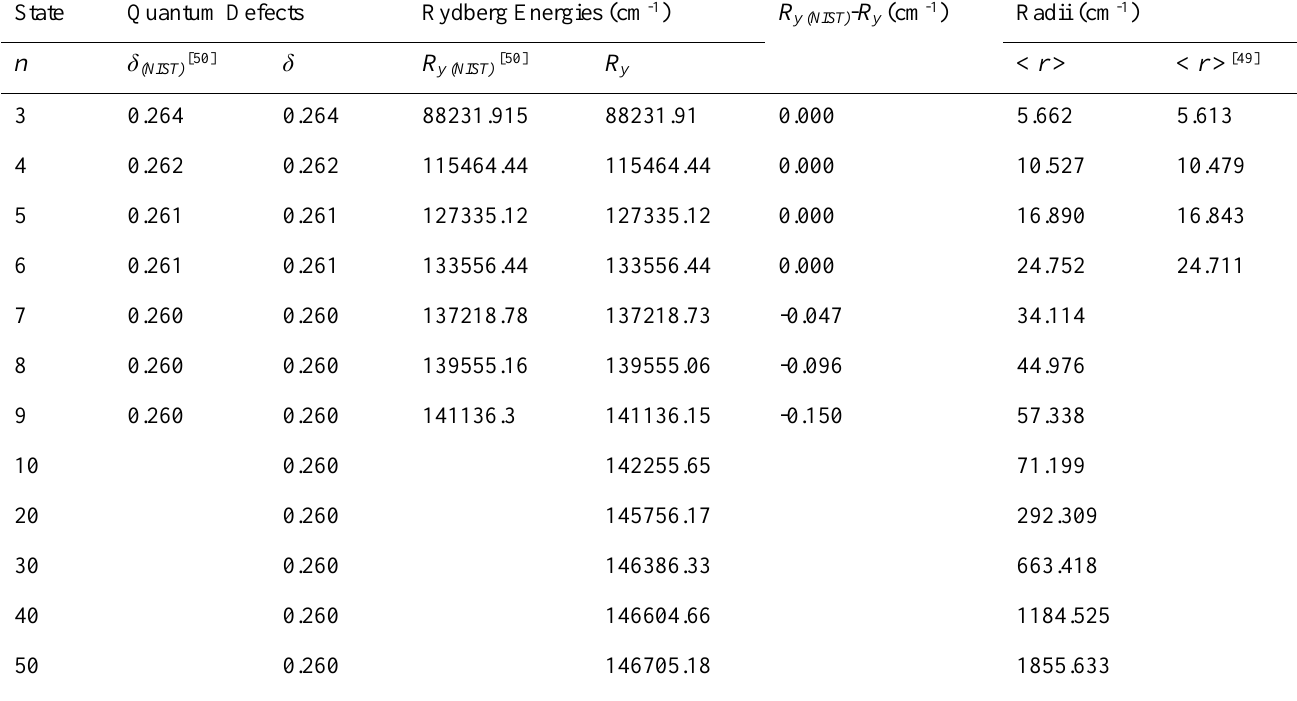
Spectral Rydberg Energy Series with Quantum Defects and Radii of Li iso-electronic sequence in 1s 2 ns 2 S e 1/2 (Be II) State Quantum